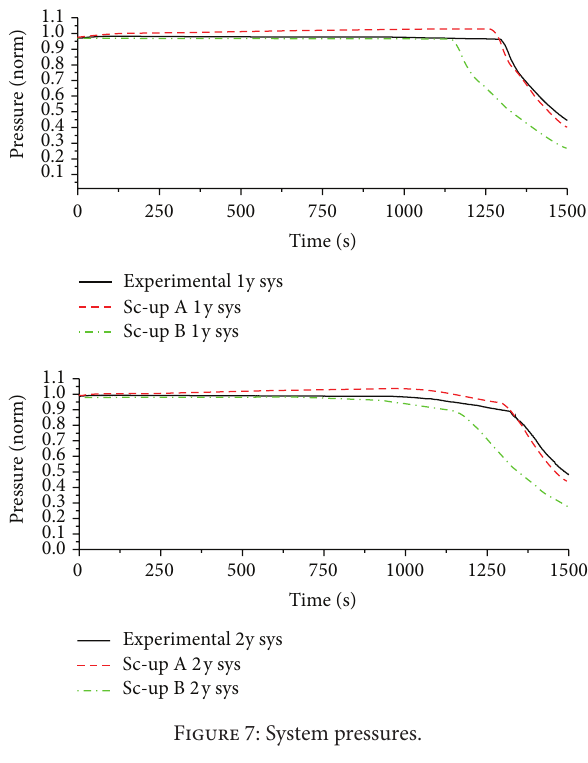
Figure 7: System